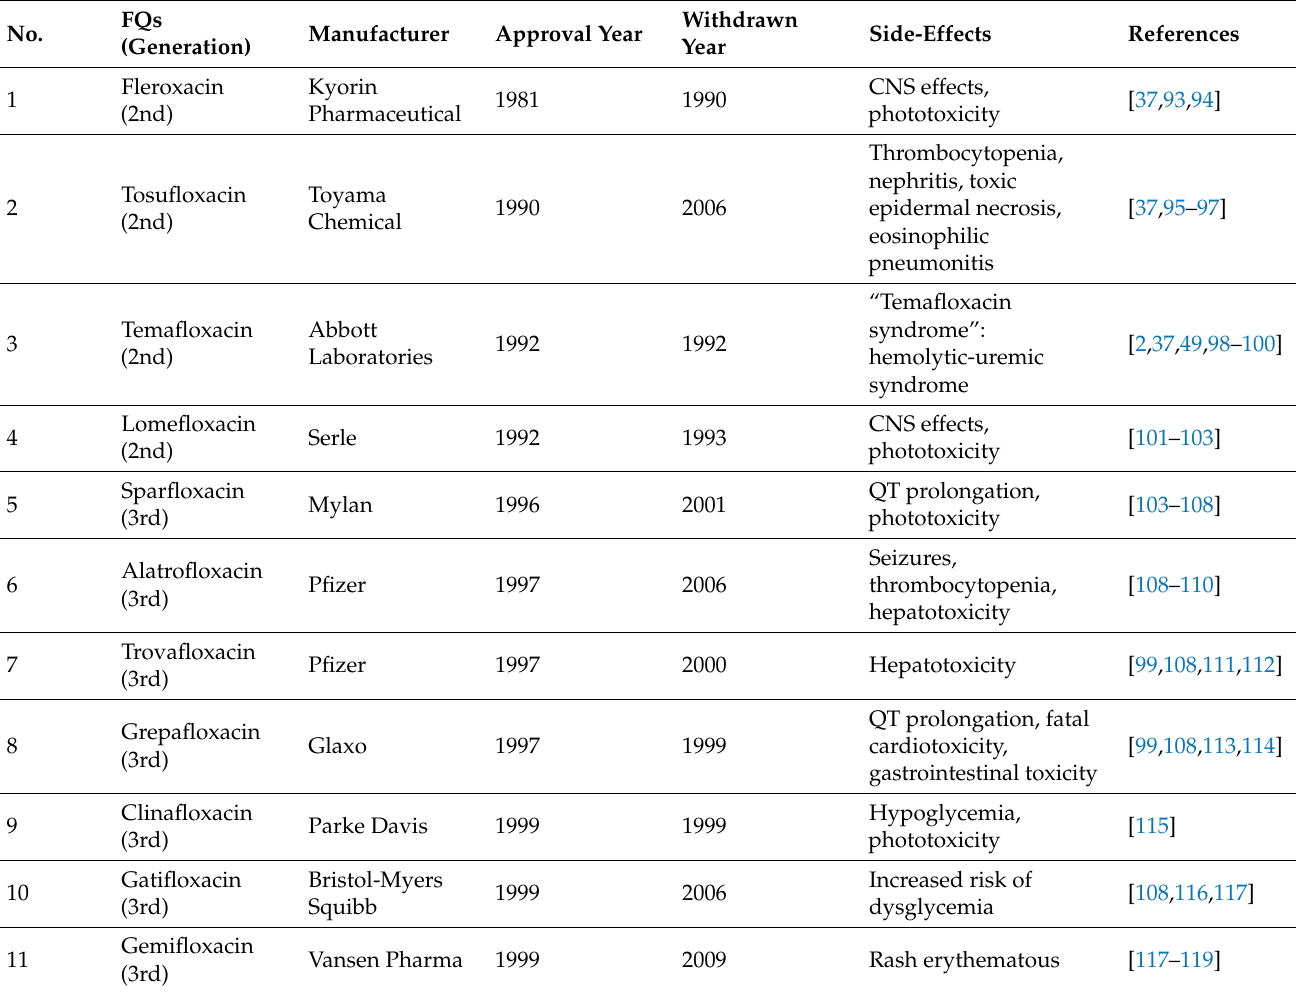
Table 3. Examples of FQs withdrawn from therapy due to severe AEs (AEs—adverse effects,